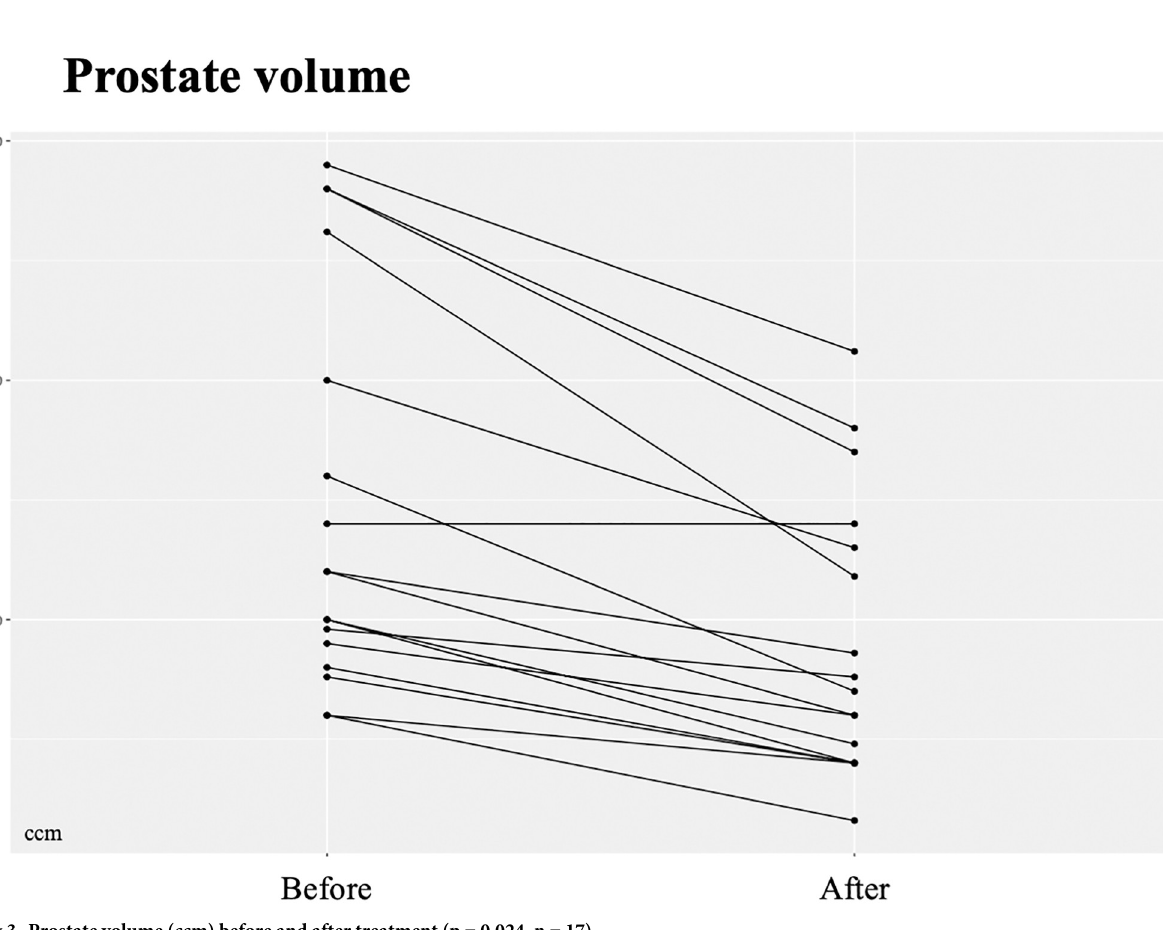
PLOS ONE | https://doi.org/10.1371/journal.pone.0279883 January 6, 2023 5 /